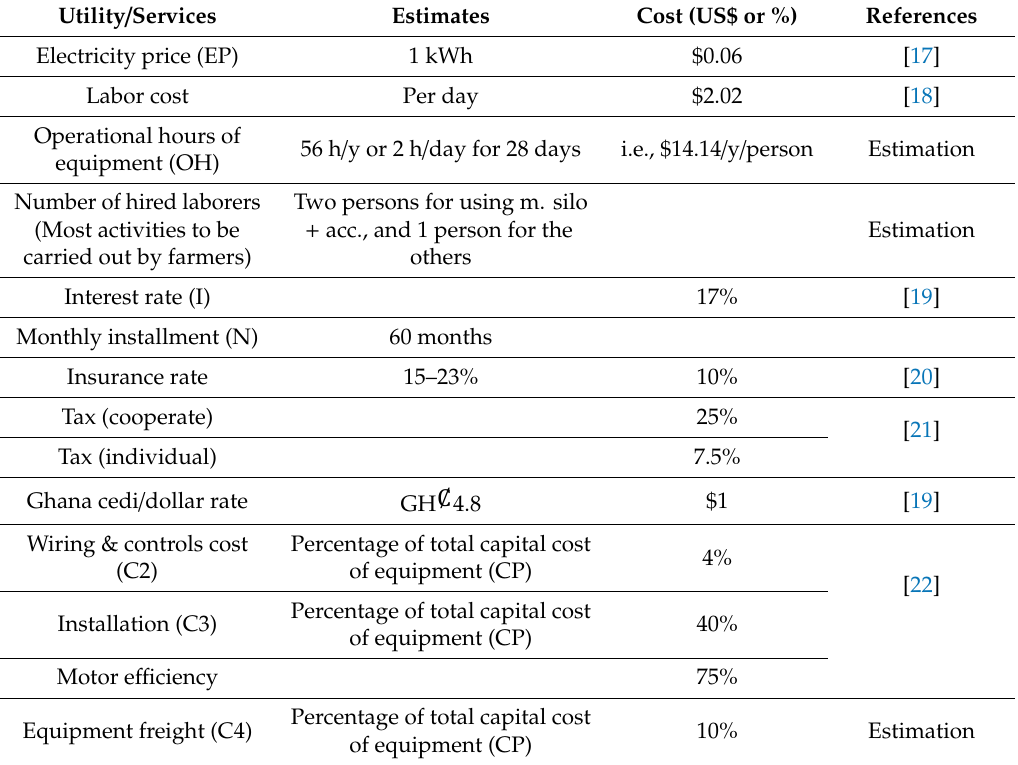
Table 3. Assumptions for utility, service, and miscellaneous prices used for the cost analysis.